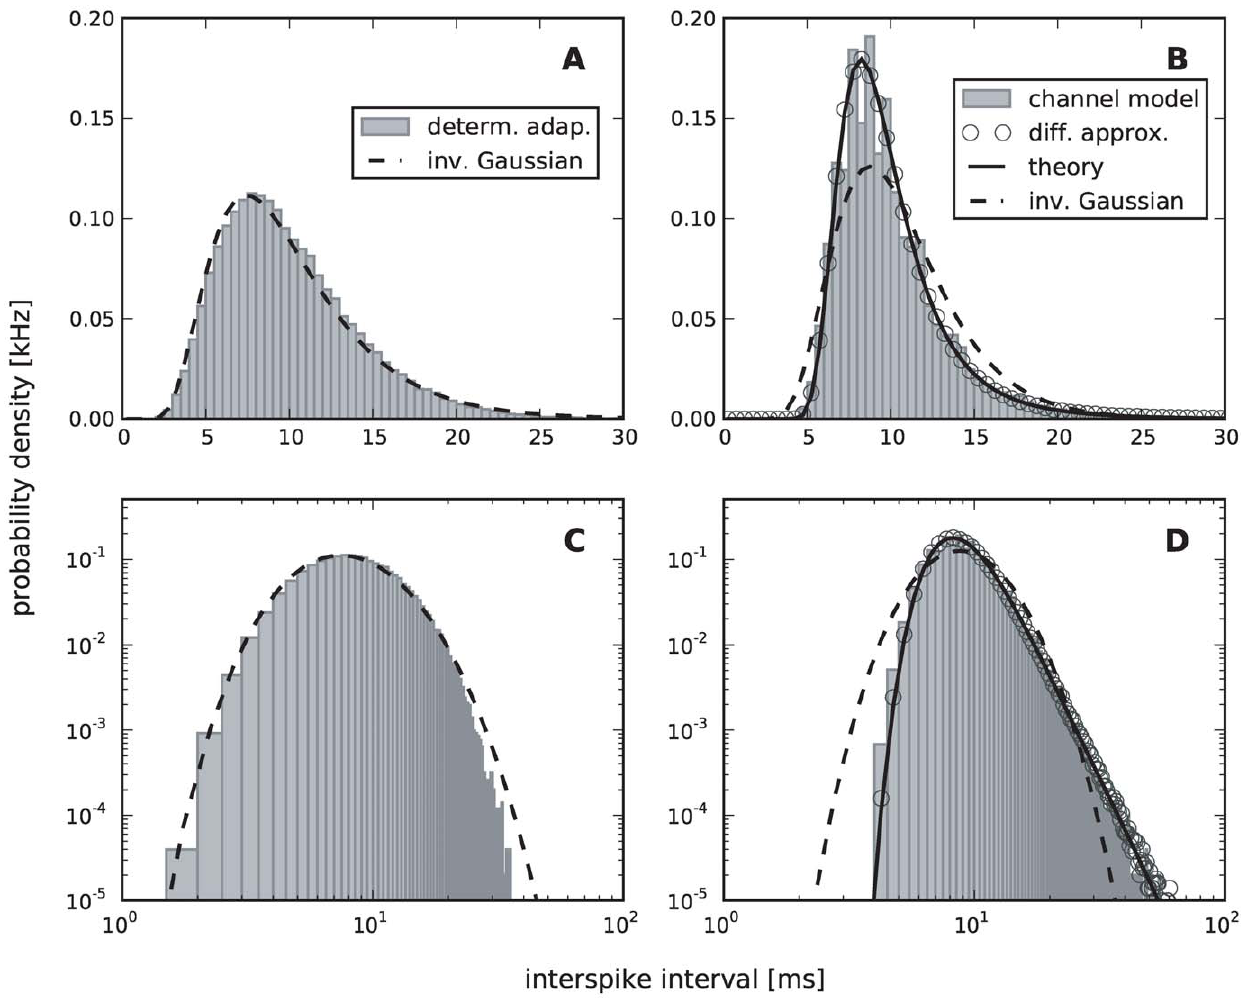
Figure 4. Comparison of ISIHs for deterministic vs. stochastic adaptation. A and C – The ISIH obtained from a simulation of the (cid:3) ms can be well described by an inverse Gaussian distribution (dashed line), deterministic adaptation model, Eq. (2), with noise intensity D ~ 0 : 01 V 2 th Eq. (64). B and D – ISIH for the stochastic adaptation model with N a ~ 200 and D ~ 0 . The channel model (gray bars) is more peaked than an inverse Gaussian distribution, Eq. (64), with the same mean and CV (dashed line). The ISIH of the diffusion model, (simulation of Eq. (3), circles) is well described by the colored noise approximation, Eq. (69), (solid line). Note the double logarithmic axis in C and D revealing the tail of the distribution. Other parameters as in Fig.